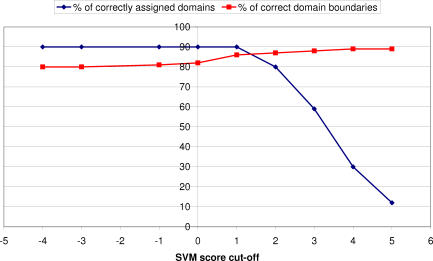
Domain Coverage Versus Quality of Domain Boundaries